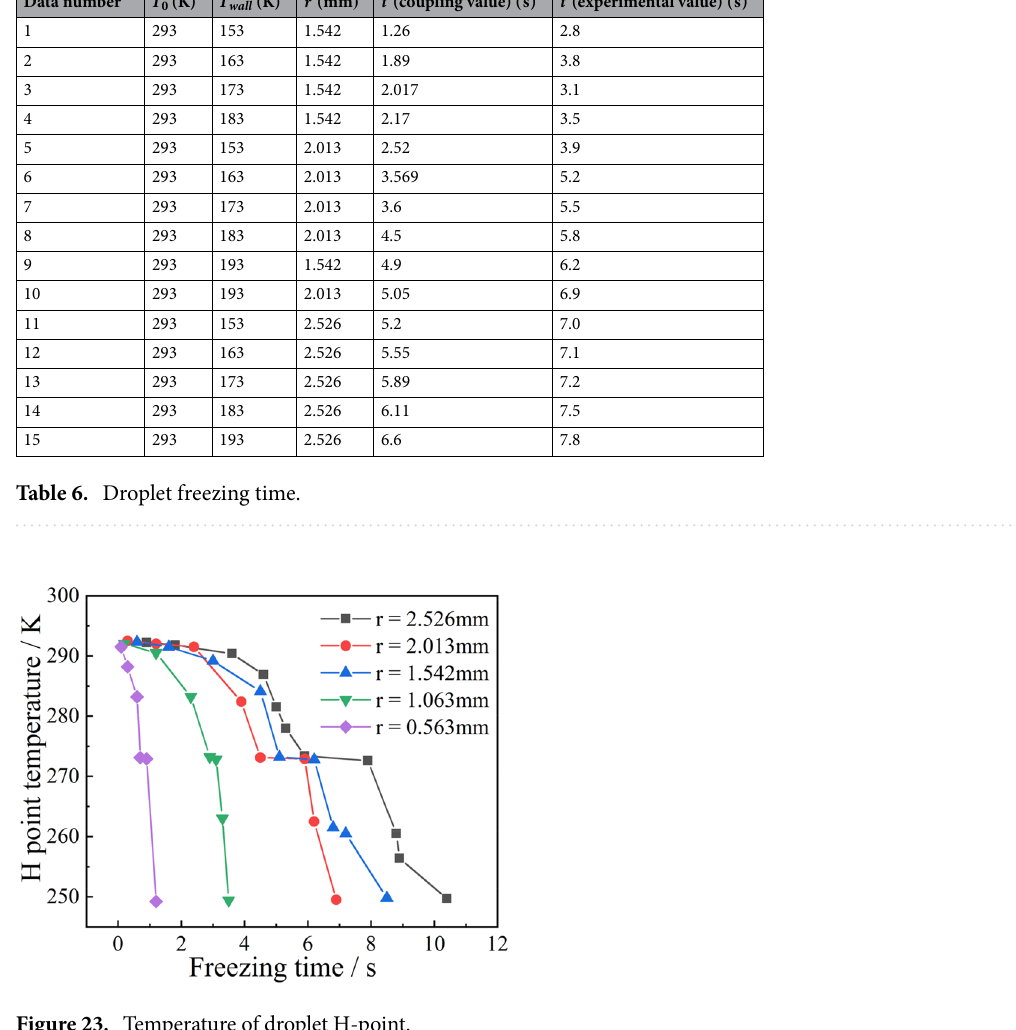
Figure 23. Temperature of droplet